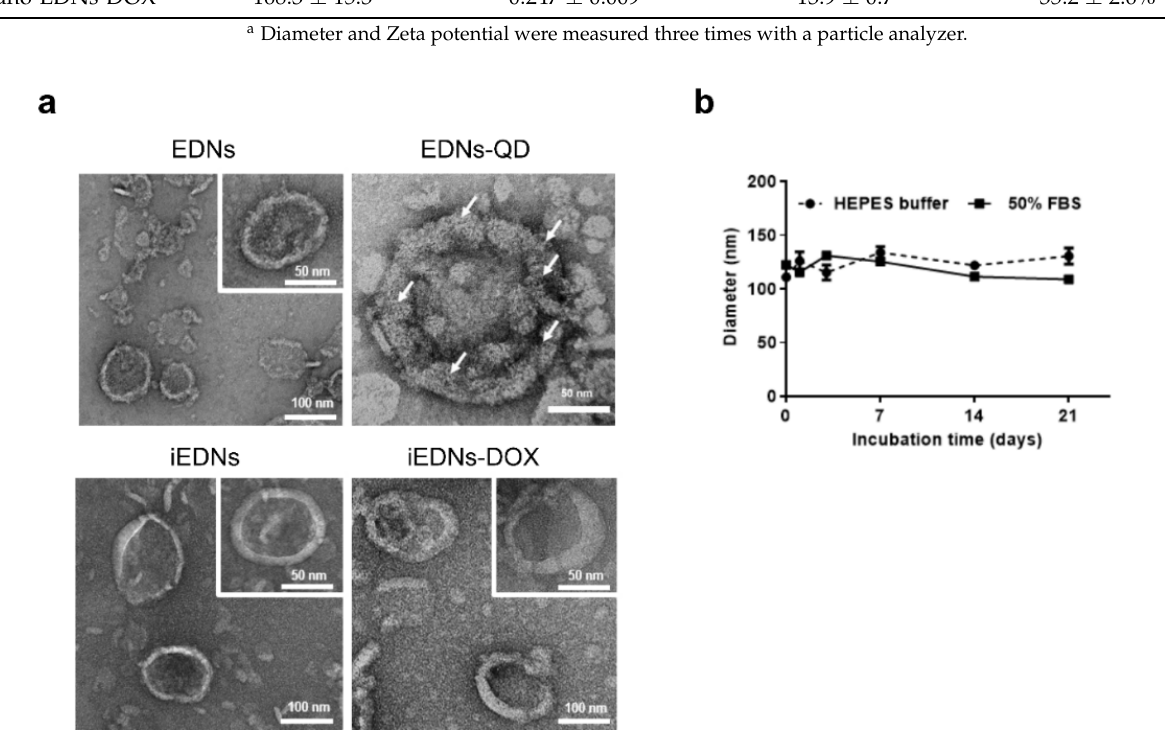
Figure 2. Changes in the morphologies and sizes of EDNs. ( a ) Morphologies of freshly prepared EDNs, EDNs ‐ quantum dots (QDs), EDNs ‐ DOX, and iEDNs ‐ DOX were observed by transmission electron microscopy (TEM). The white arrows indicate QDs. ( b ) Sizes of EDNs in serum ‐ free HEPES